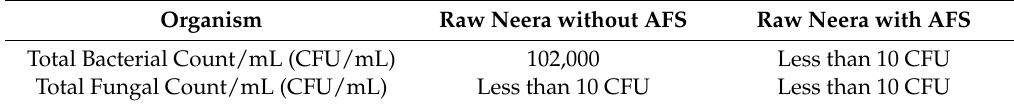
Table 1. The microbial load of raw coconut Neera with and without AFS.